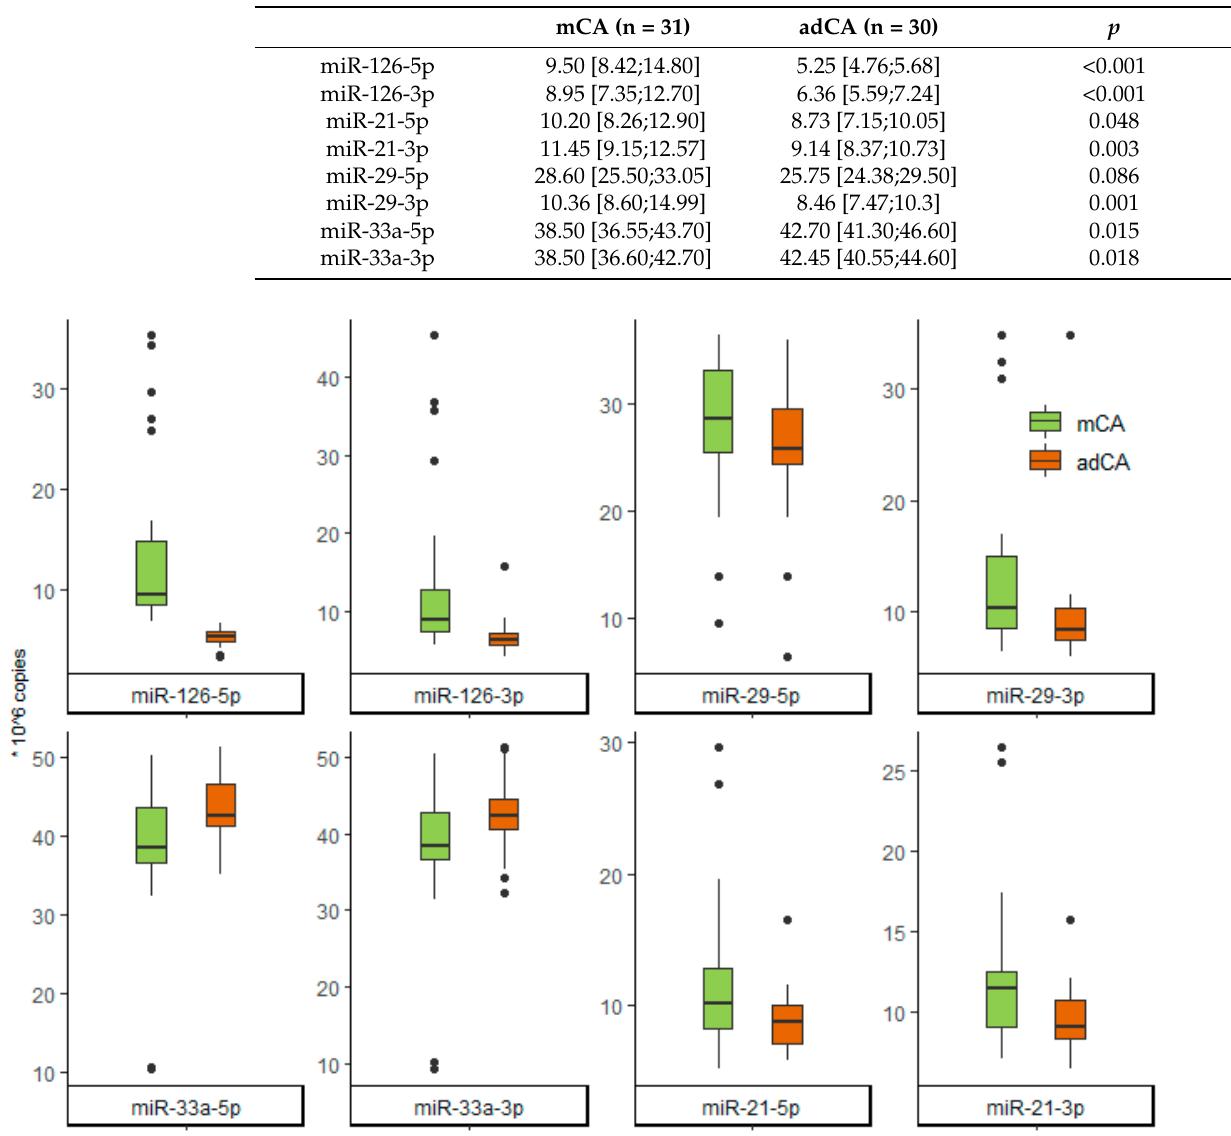
Figure 2. Box plot of microRNA expression levels in the study population ( × 10 6 copies). The thick horizontal line represents the median; thin horizontal lines the 1st and 3rd quartile; vertical lines indicate the spread (outliers (dots) are not removed).